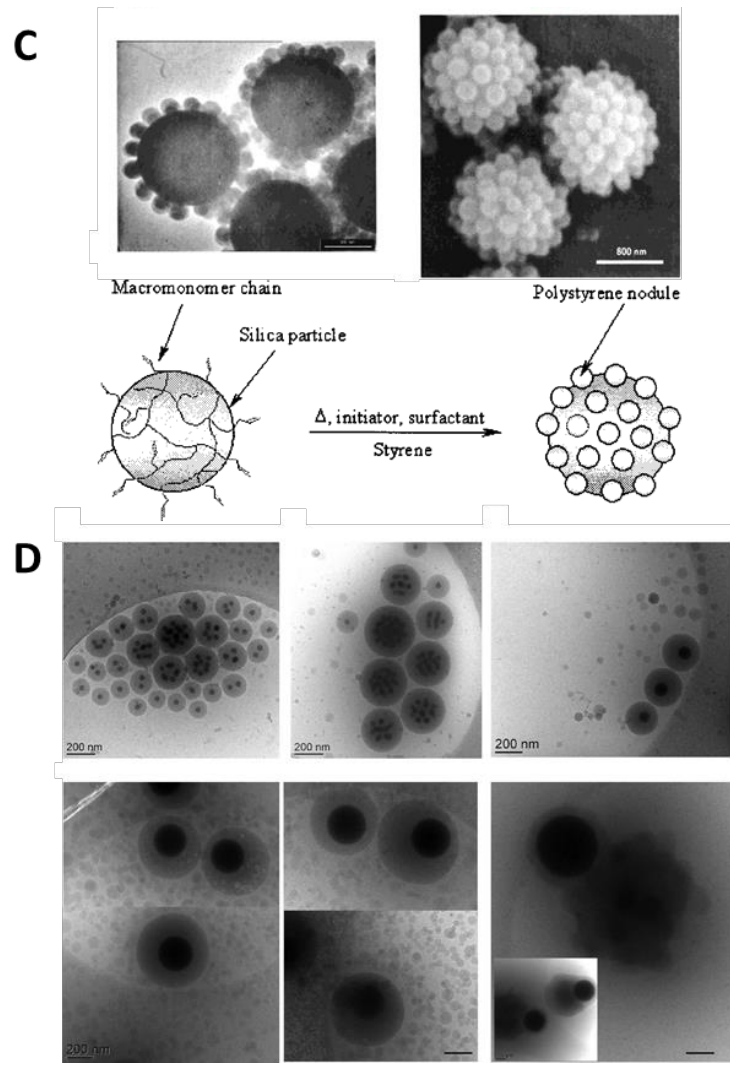
Figure 7. Hybrid particle morphology. ( A ) Dissymmetrical snowman- and dumbbell-like sil- ica/polymer colloidal particles through emulsion polymerization of MMA or St using bicationic initiator previously anchored on the silica surface. Reprinted with permission from ref. [113]. Copy- right 2012 ACS. ( B ) Hexapods obtained by St emulsion polymerization. Reprinted with permission from ref. [112]. Copyright 2012 The Royal Society of Chemistry. ( C ) Raspberry-like hybrids based on 1- µ m silica particles. Reprinted with permission from ref. [114]. Copyright 2002 ACS. ( D ) Encapsu- lated SNPs showing the effect of the SNPs size on the morphology of the hybrid particles (scale bar: 200 nm). Reprinted with permission from ref. [116]. Copyright 2016 ACS.